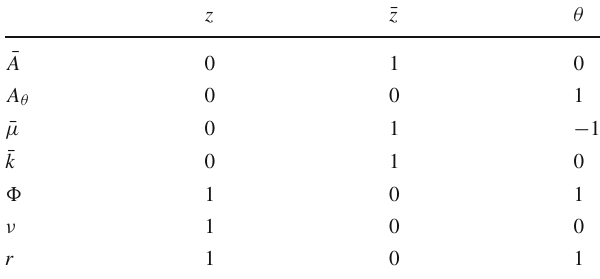
Table 1 Dimensions of